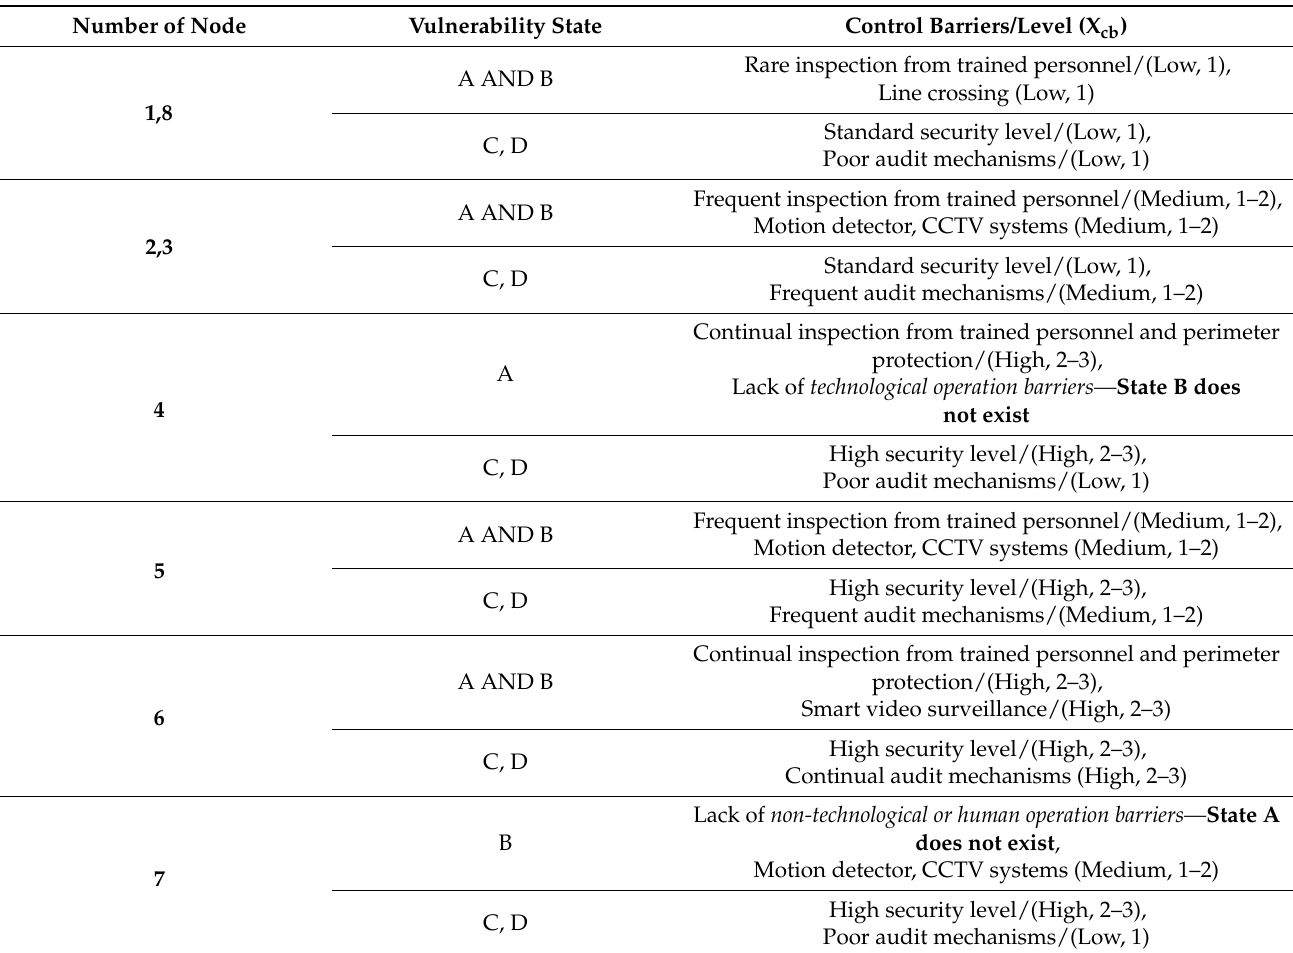
Table 5. Case study description and level of control barriers per vulnerability state for every